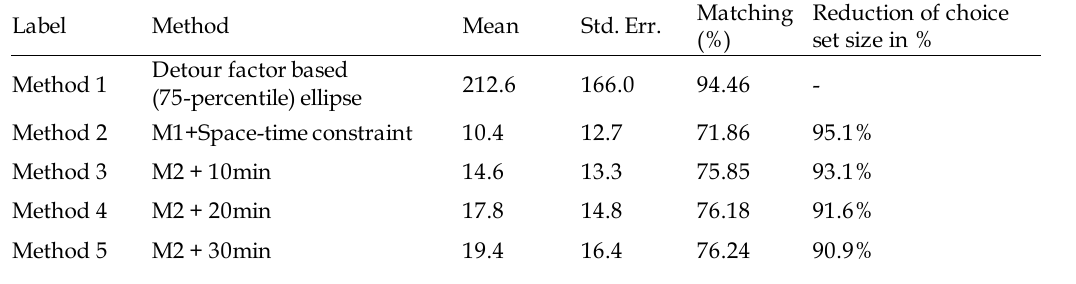
Table 4. Location choice set size and its matching with the observation under different location choice set generation methods